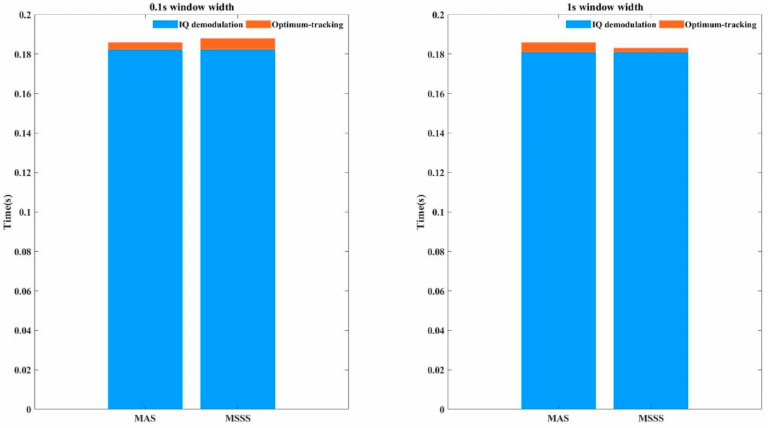
Figure 13. Algorithm time